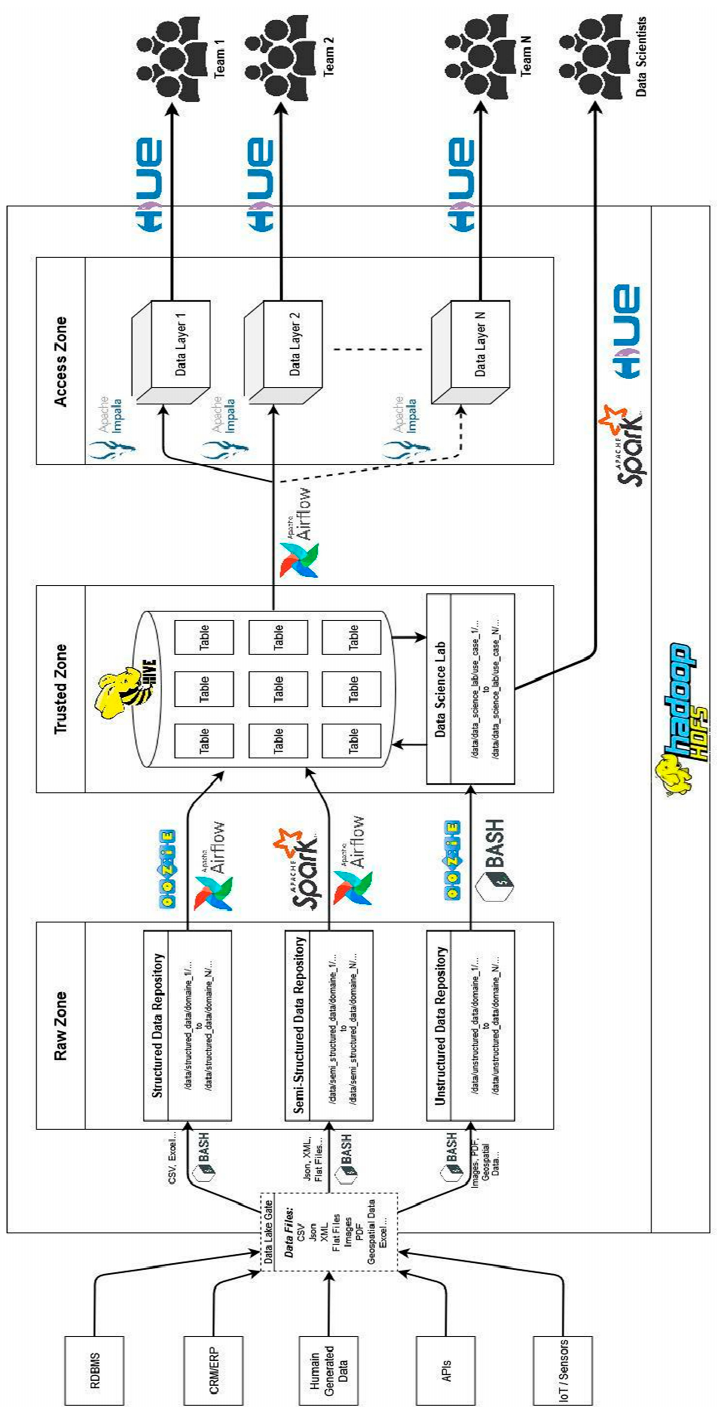
Figure 2. Fish Farming Data Lake Technical Architecture.